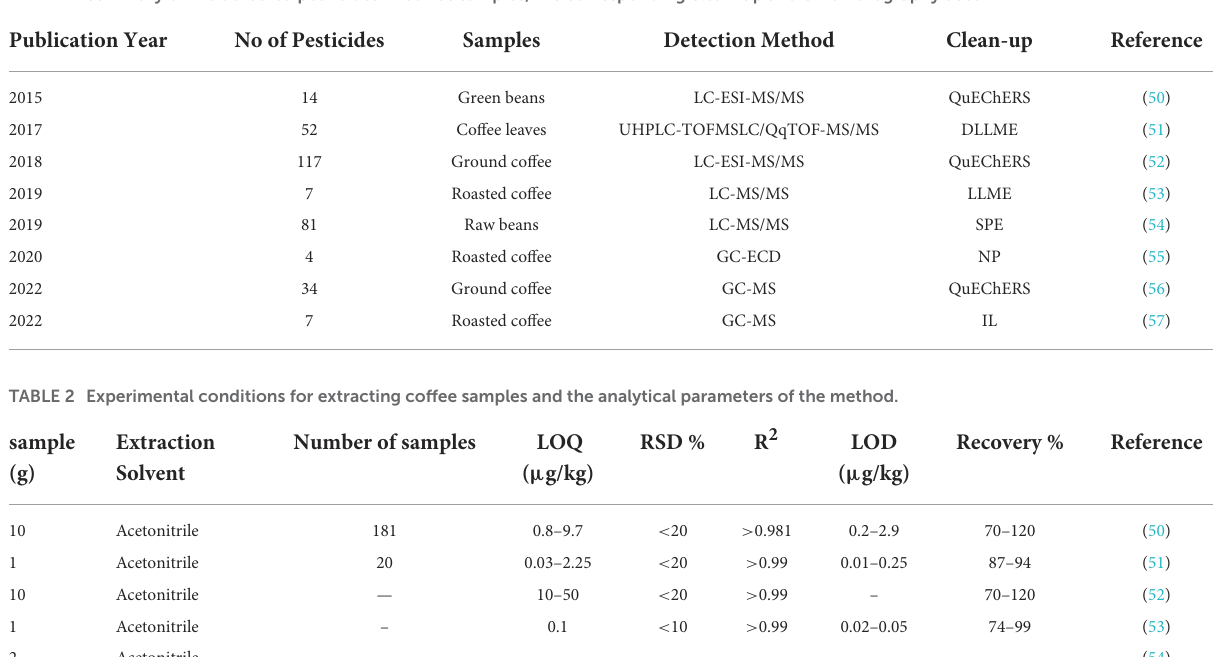
TABLE 1 Summary of the detected pesticides in coffee samples, the corresponding clean-up and chromatography used.